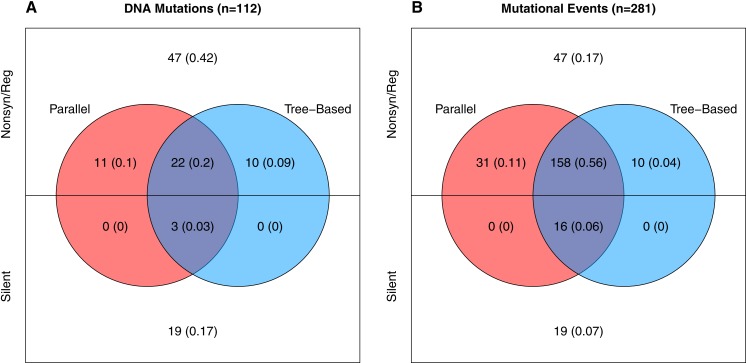
Number and evidence of adaptive mutations.(A) All 112 unique mutations. (B) All 281 mutational events (where the contribution of each mutation is the number wells it appears in). Mutations in colored regions are likely adaptive because they are observed in more than one well independently (red), because one or more well phylogenies implies they rose above low frequency (blue), or both (purple). Mutations in white lack evidence of being adaptive.